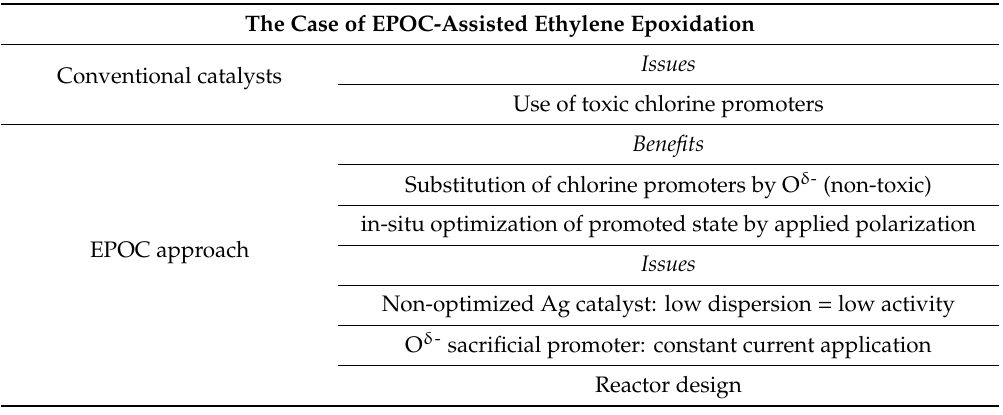
Table 1. Main issues and benefits of the EPOC-assisted ethylene